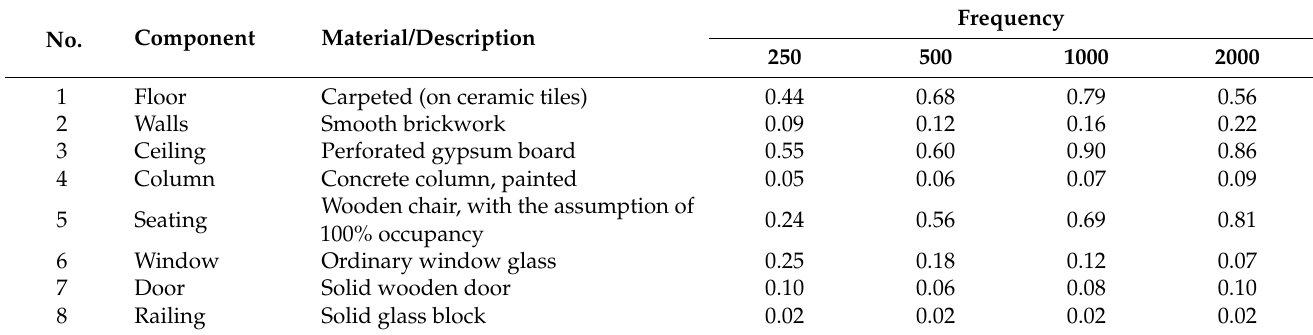
Table 7. Sound absorption coefficient of the materials used in the simulated models.